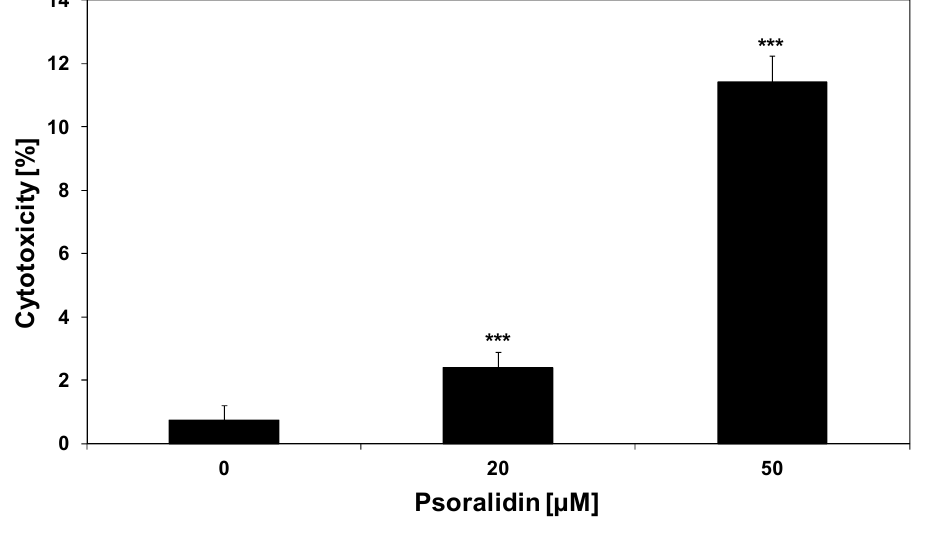
Figure 2. Cytotoxic activity of psoralidin in HeLa cancer cells. The cancer cells were incubated for 48 h with psoralidin at the concentrations of 20 μ M and 50 μ M. The percentage of cell death was measured by MTT cytotoxicity assay. The values represent mean ± SD of three independent experiments performed in quadruplicate (n = 3) ( *** p < 0.001 compared with